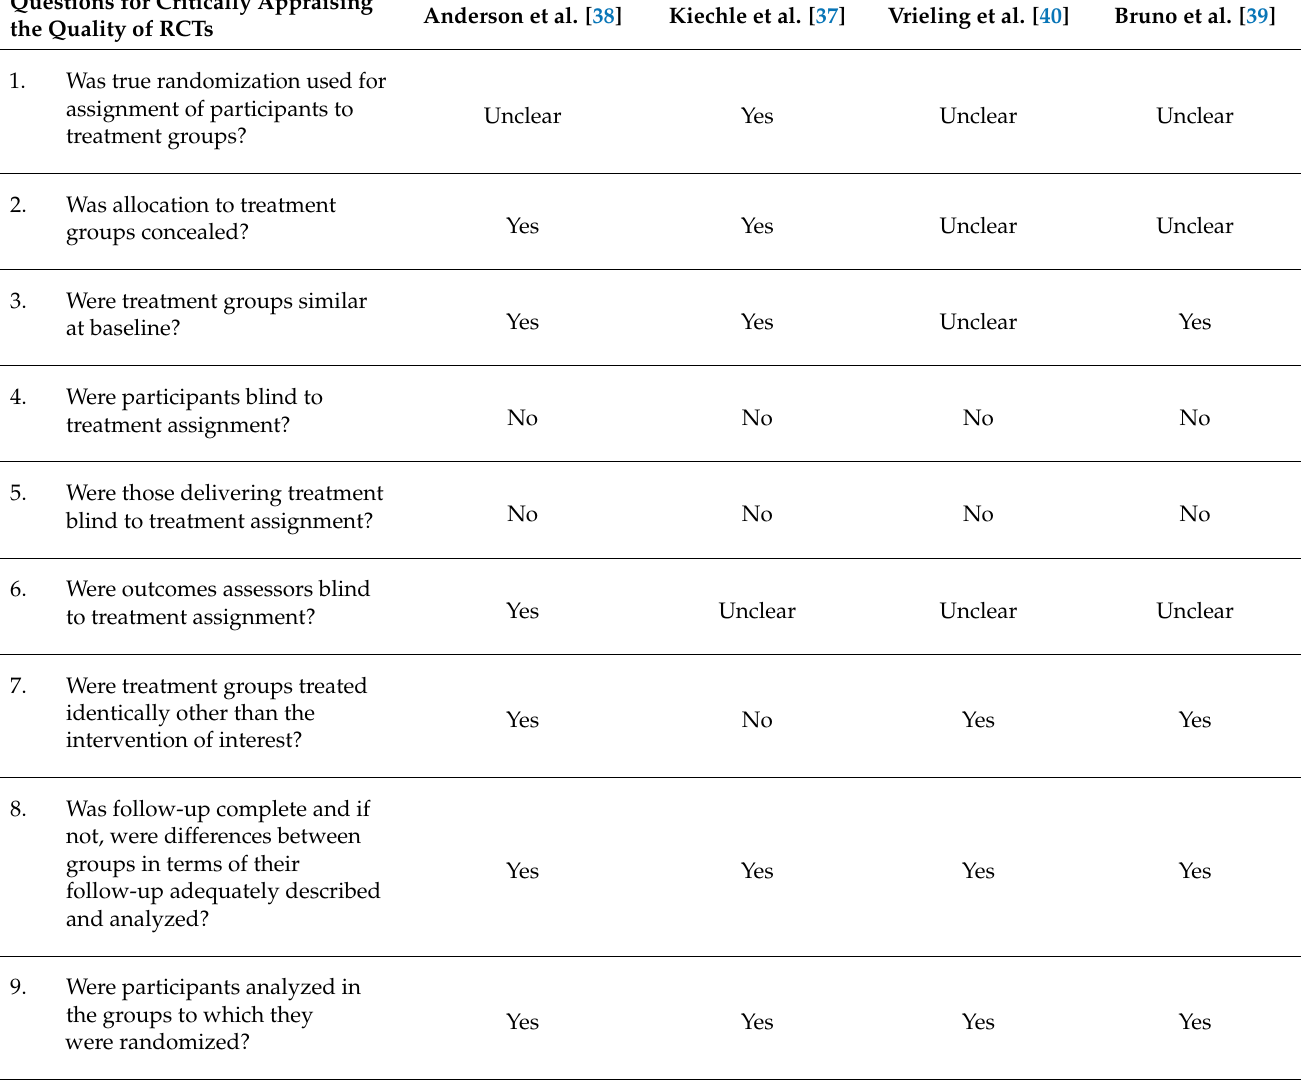
Table 2. Quality assessment using the Joanna Briggs Institute critical appraisal tools for RCTs